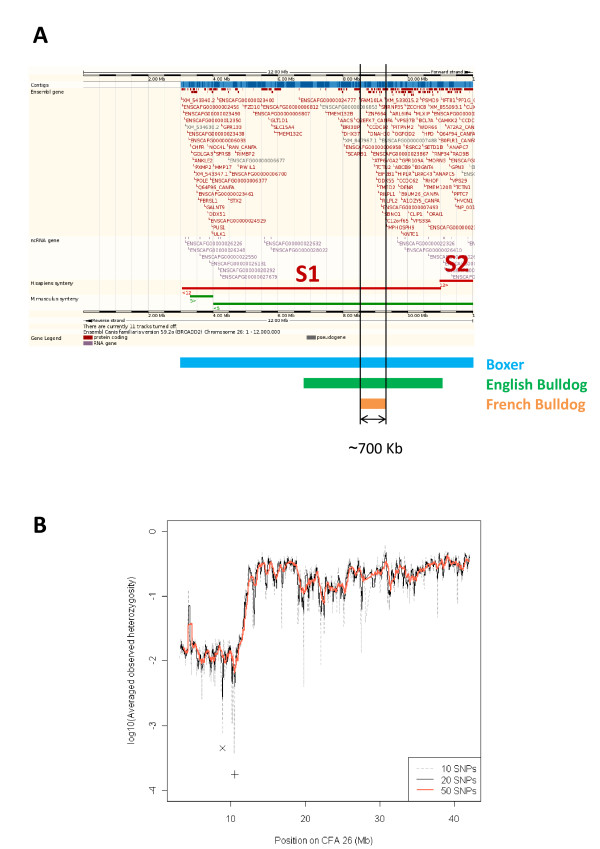
Genetic content of the ROH on CFA 26. (a) Annotated elements in the dog genome (CanFam2.0) as well as regions of synteny with H. sapiens and M. musculus are shown. CFA 26:3,008,718-11,914,284 bp maps to two syntenic regions in H. sapiens: Hs 12:121,547,433-133,784,108 bp (S1) and Hs 12:110,448,771-121,498,418 (S2). The end position for S2 is defined relative to the end of the ROH in dog though indeed synteny extends longer. Note that the order of the syntenic regions relative to the dog sequence indicates rearrangements events in the species; also, the different orientation of the sequences, indicated with arrows preceding the chromosome number in the compared species, designates an inversion in the orientation between H. sapiens and C. familiaris for S1. Regions of extended homozygosity for Boxer, English bulldog and French bulldog and the region of ~700 Kb shared in all three are indicated. (b) Averaged observed heterozygosity along CFA 26 in Boxer. Minimum values are shown for three window sizes: 10- and 50-SNPs, CFA 26:8.86 Mb (x); 20-SNPs, CFA 26:10.44 Mb (+).